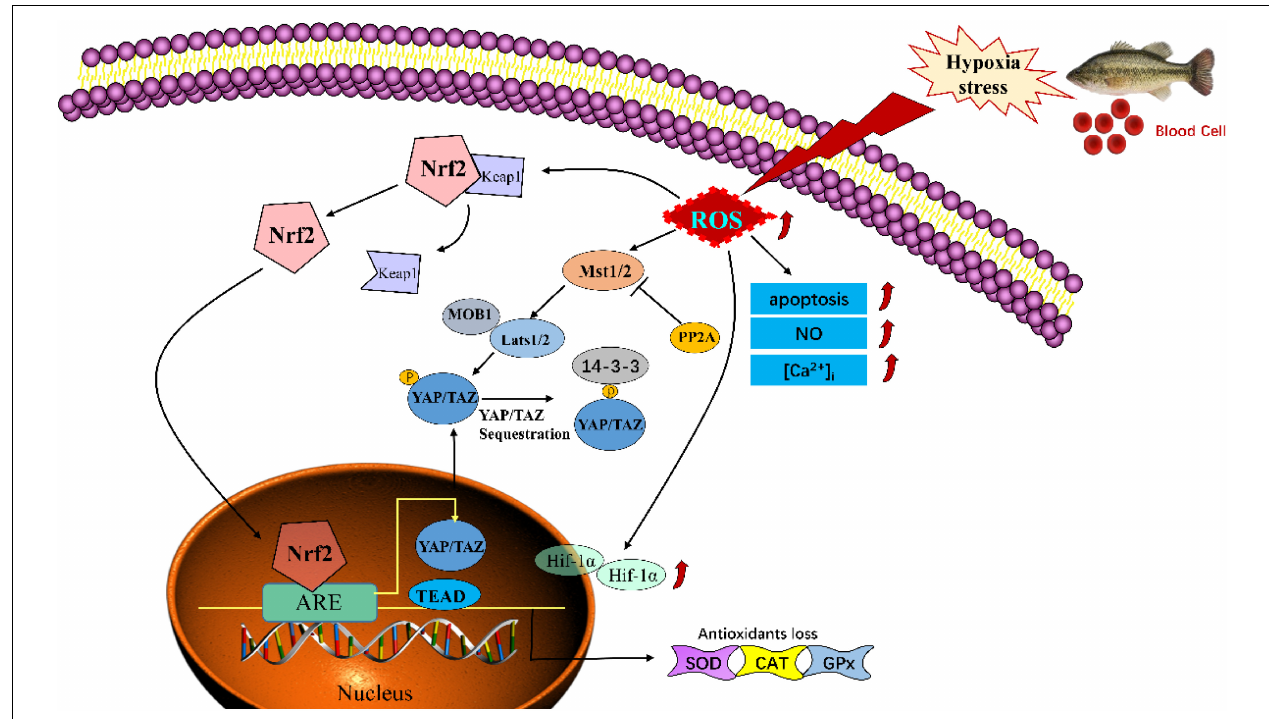
FIGURE 9 | Schematic model of hypoxia -induced injury via mediating the Nrf-2/Hippo pathway in blood cells of Largemouth bass ( Micropterus salmoides ).